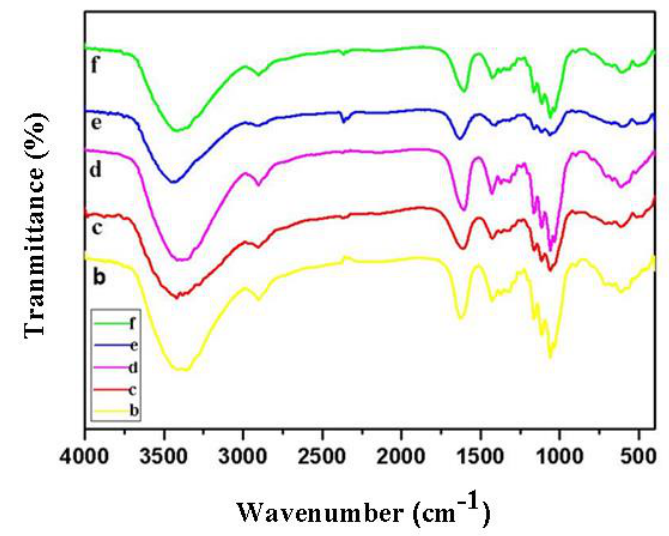
Figure 3. FT-IR spectra of cellulose-COOZn (b), cellulose-COOMg (c), cellulose-COOCa (d), cellulose-COONa (e), and cellulose-COOBa (f).